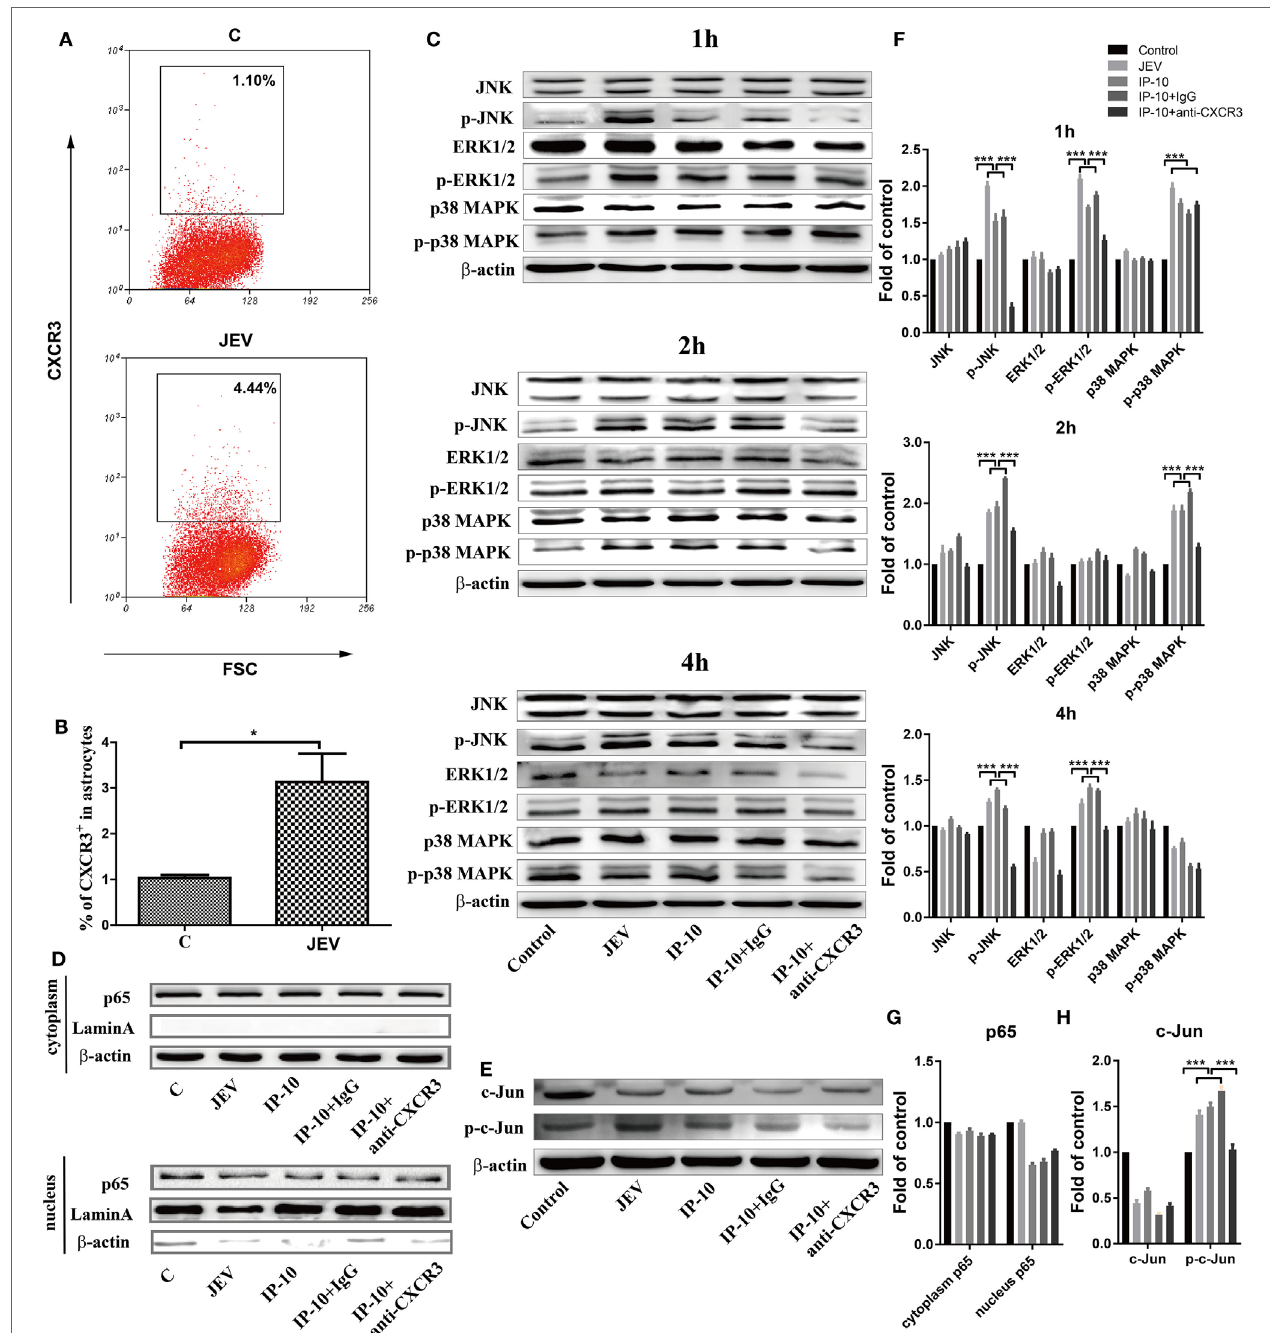
FigUre 7 | Pathway analysis of Japanese encephalitis virus (JEV) and IP-10 on primary astrocytes. (a) Confluent primary astrocytes were treated with Dulbecco’s modified Eagle’s medium (DMEM) (c) or JEV (5 MOI). At 24 h postinfection, the cells were digested and analyzed via flow cytometry. The data are representative of three independent experiments (gated on live cells). (B) Quantification of CXCR3 + cells in panel (a) . The data are expressed as the means ± SEMs from three independent experiments. (c) Western blotting analysis of p38 mitogen-activated protein kinase (MAPK), ERK1/2, and JNK phosphorylation in primary astrocytes. Confluent astrocytes were treated with JEV (5 MOI), IP-10 (200 ng/ml), IP-10 combined with IgG isotype control (50 µg/ml), IP-10 combined with anti-CXCR3 antibody (50 µg/ml), and DMEM (control). The protein samples were collected at 1, 2, and 4 h after treatment, and corresponding antibodies were used to measure the target proteins. The data are representative of three independent experiments. (D) The translocation of nuclear factor κ B p65 after treatment with JEV, IP-10, IP-10 combined with IgG, IP-10 combined with anti-CXCR3 antibody, and DMEM for 24 h was measured by Western blotting. The data are representative of three independent experiments. (e) Transcription factor c-Jun and phosphorylated c-Jun were detected by Western blotting 4 h after treatment. (F,g,h) The expression of proteins in panels (c–e) were normalized to that of β -actin and quantitatively analyzed as the fold-change relative to the control, respectively. The data are representative of three independent experiments. * p < 0.05; *** p <